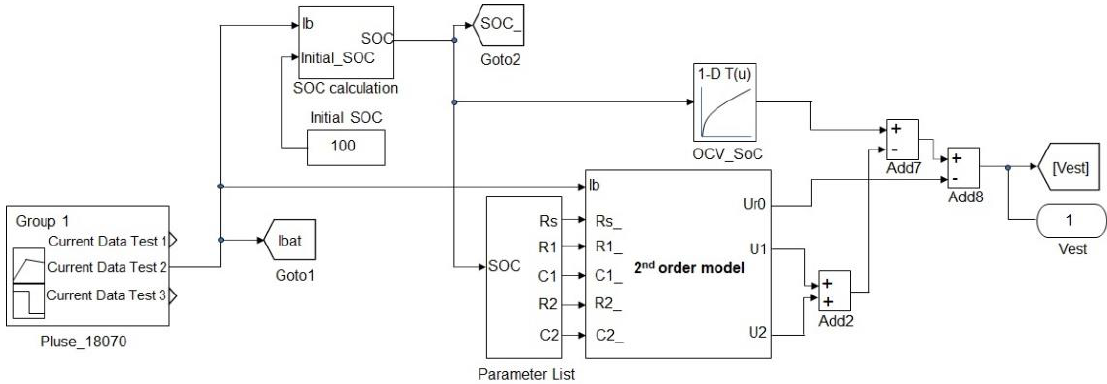
Figure 4. Simulink diagram for the second-order RC ECM.